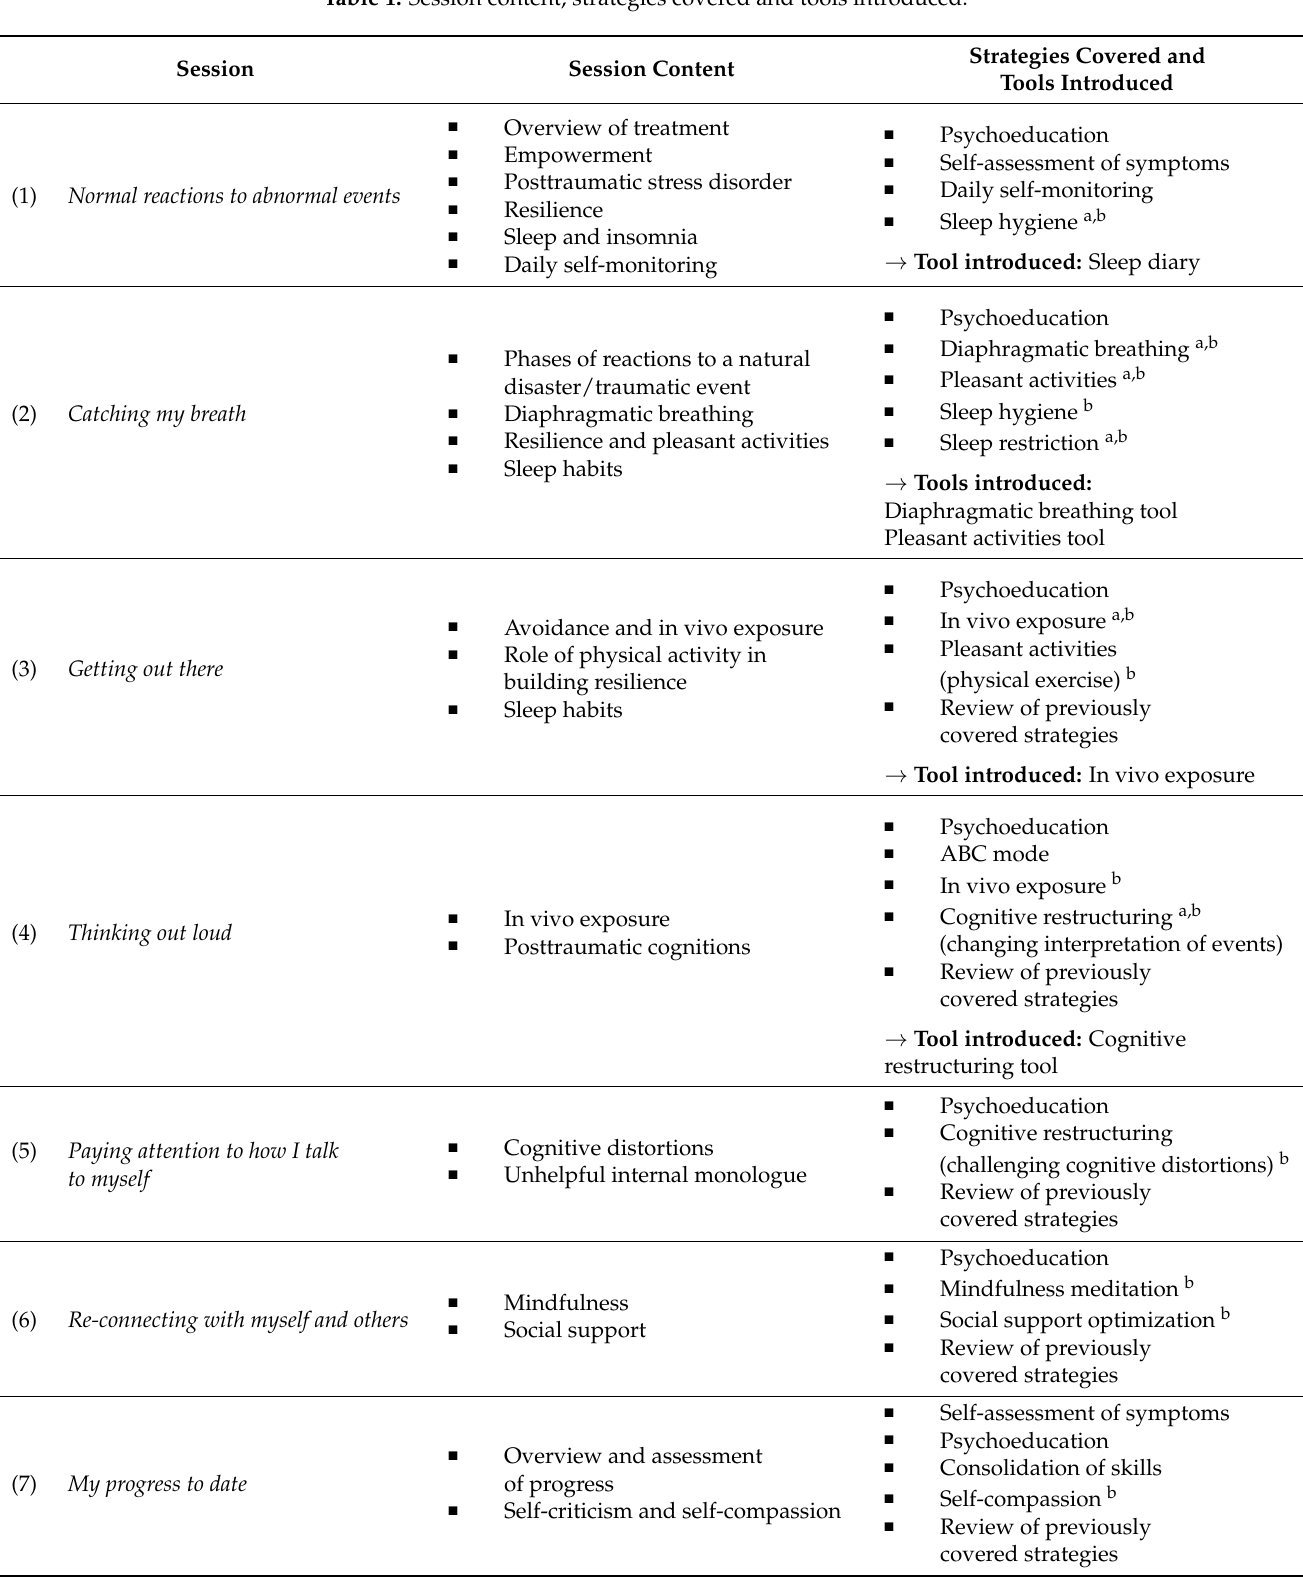
Table 1. Session content, strategies covered and tools